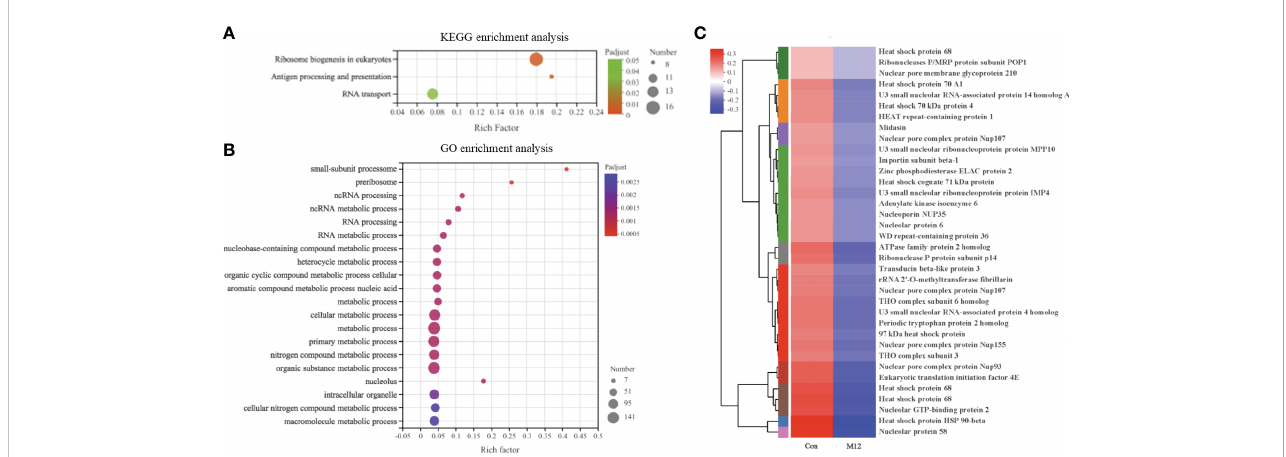
FIGURE 5 The functional enrichment and expression analysis of fi nal-response genes to oyster induction. (A) KEGG enrichment results of 597 DEGs in Con vs. M12 comparison. (P adjust < 0.05). (B) GO enrichment results of 597 DEGs in Con vs. M12 comparison. (P adjust < 0.05). (C) Heat map of the expression analysis of 36 DEGs in the enriched pathways: “ Ribosome biogenesis in eukaryotes ” , “ Antigen processing and presentation ” and “ RNA transport ” .